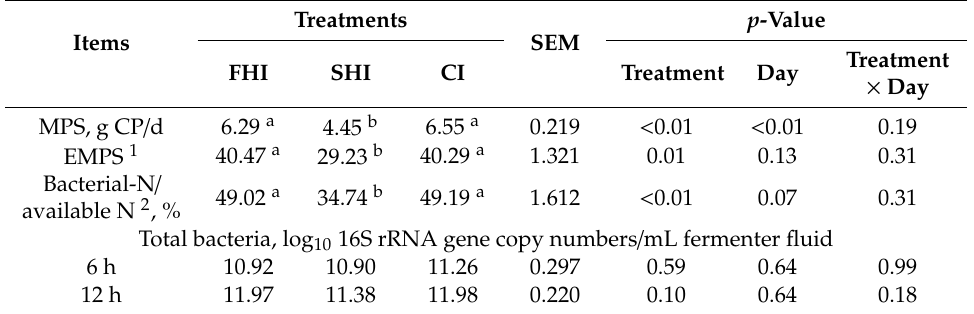
Figure 7. Activities of enzymes involved in ammonia assimilation among treatments. Values are means, with standard errors represented by vertical bars. a,b Mean values with unlike letters were significantly di ff erent ( p < 0.05). GS, glutamine synthetase; GOGAT, glumate synthetase; GDH, glutamate dehydrogenase; ADH, alanine dehydrogenase. FHI, first half infusion of maltodextrin; SHI, second half infusion of maltodextrin; CI, continuous infusion of maltodextrin. Table 4. E ff ect of degrees of synchronization on microbial protein synthesis and total bacterial counts. p -Value Treatments Items SEM FHI SHI CI Treatment